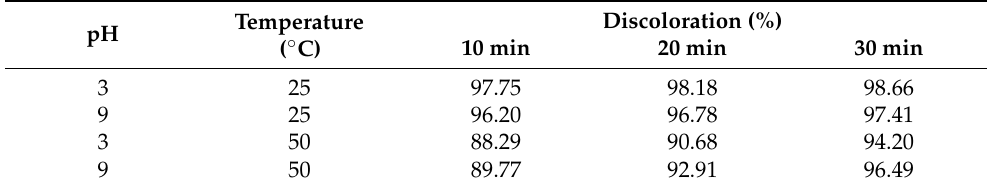
Table 1. Percentage of discoloration for each photocatalysis reaction using the Cu 2 (OH) 3 (OCOCH 3 ) as